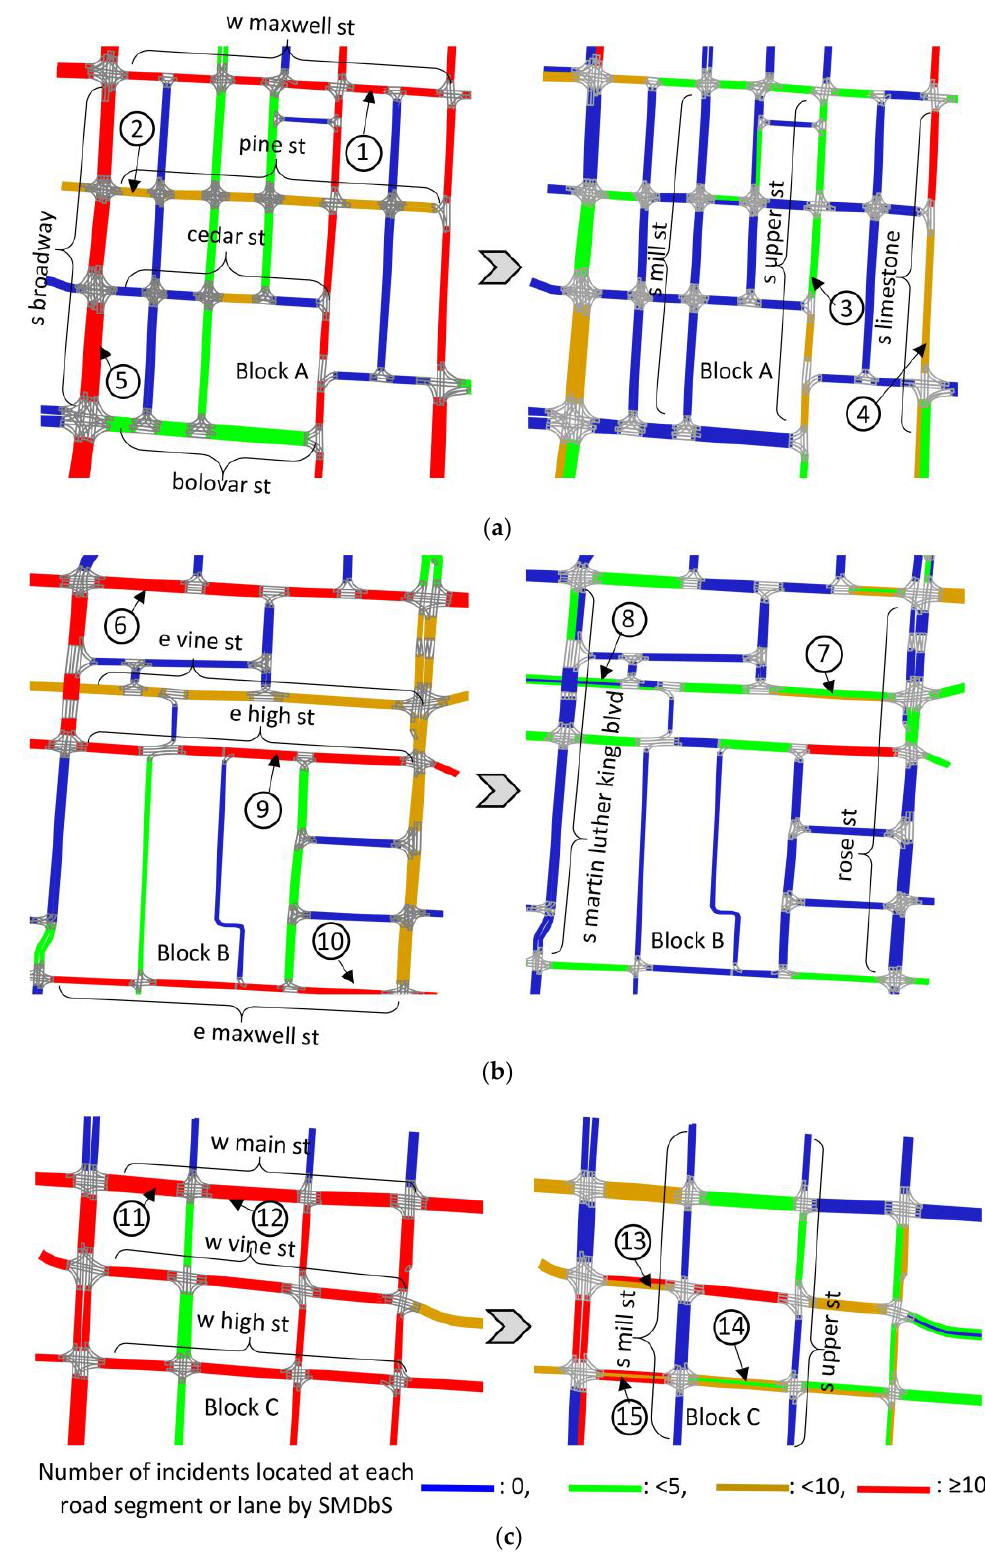
Figure 6. Granularity comparison between existing SMDbSs and the newly proposed SMDbS in three downtown blocks.